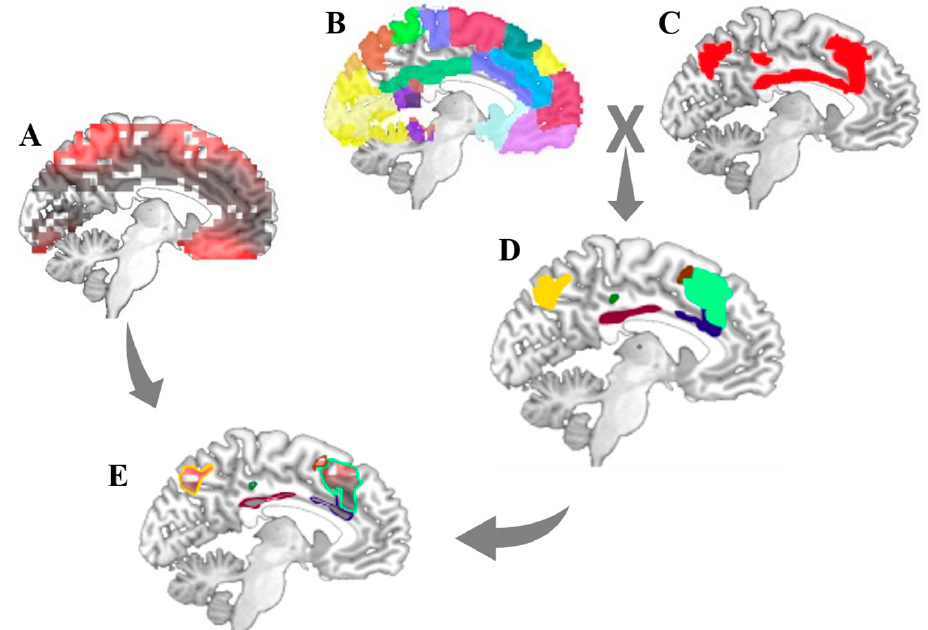
Figure 1. The flow chart to extract the time series of activation from each network’s hubs. ( A ) electrical activity of each voxel based on sLORETA, ( B ) MRI based binary templates of Brodmann areas maps, ( C ) MRI based binary templates of network mask (e.g., CEN), ( D ) the network’s hubs based on the intersect between network mask and Brodmann area masks, and ( E ) time series of activation in the network’s hubs.